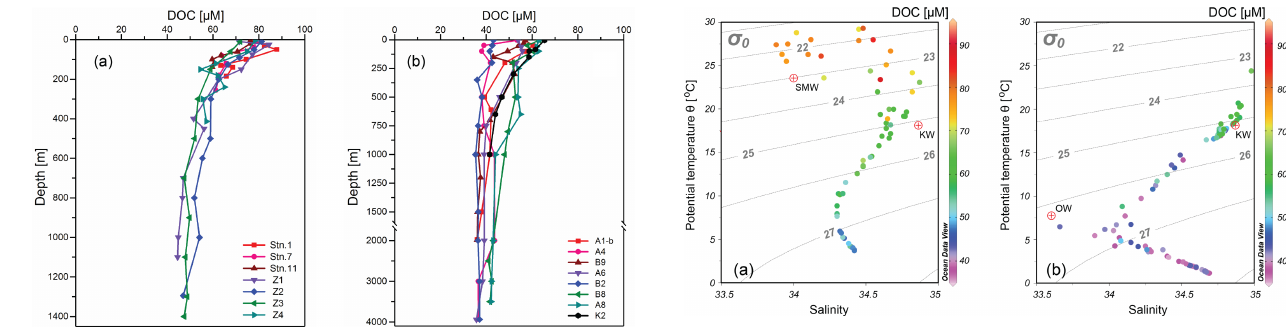
Figure 3. Depth profiles of DOC concentrations measured for the stations in the (a) ECS and (b) northwestern North Pacific during the two cruises in 2014–2015. Note in panel (b) that the depth below 1500m is on a different scale.